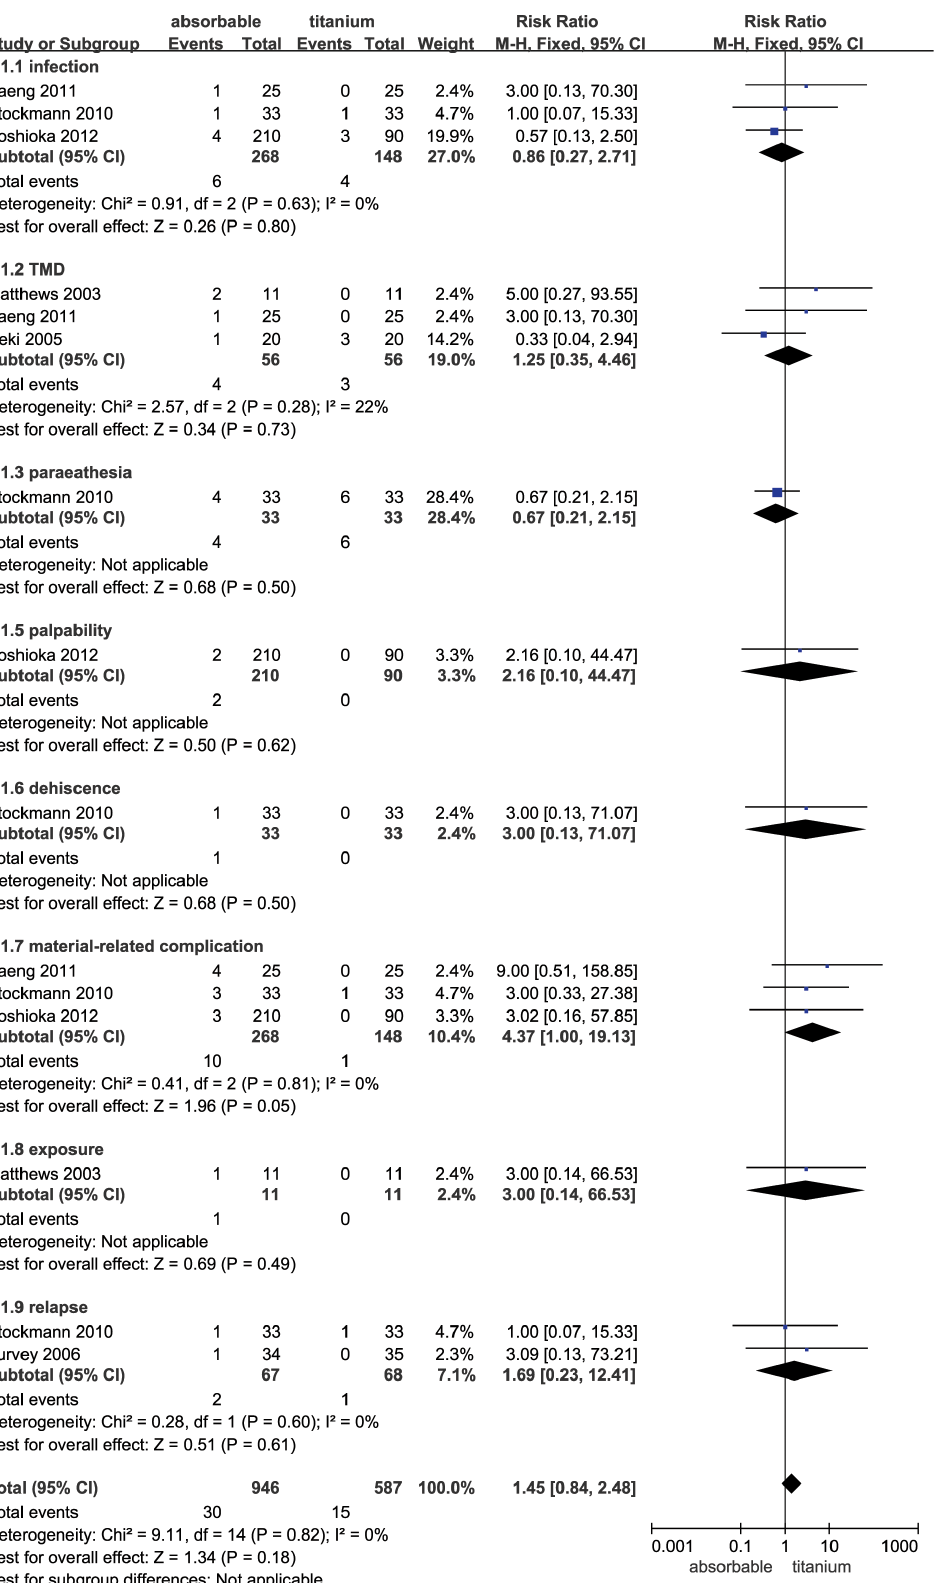
Figure 5. Forest plot of trials of absorbable fixation versus titanium examining the effect on relative risk of complications in BSSRO. See Figure 2 legend for expansion of abbreviations.